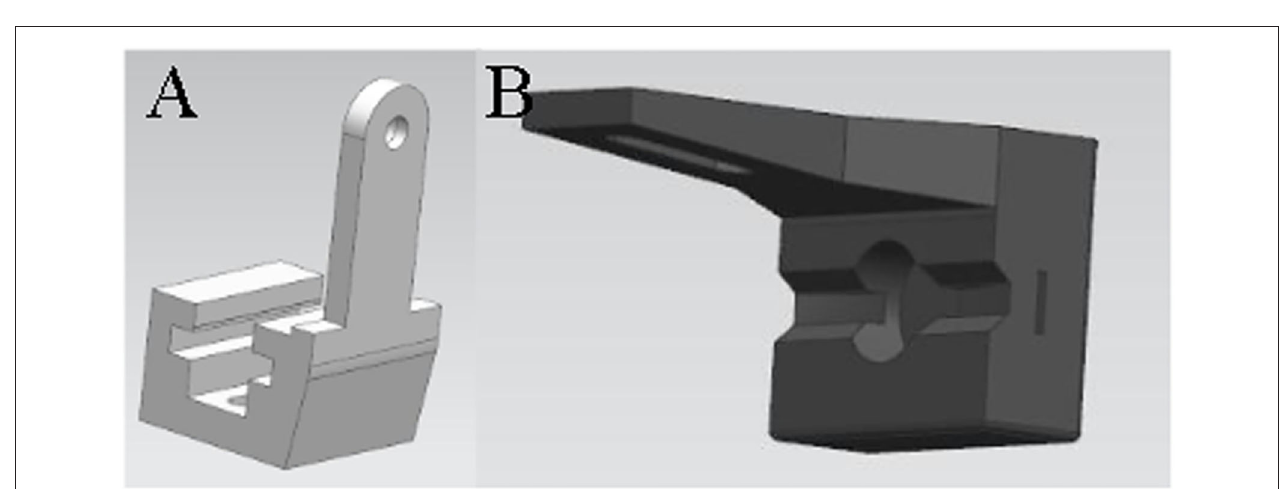
FIGURE 2 | (A) 3D modeling of slider (B) 3D modeling of